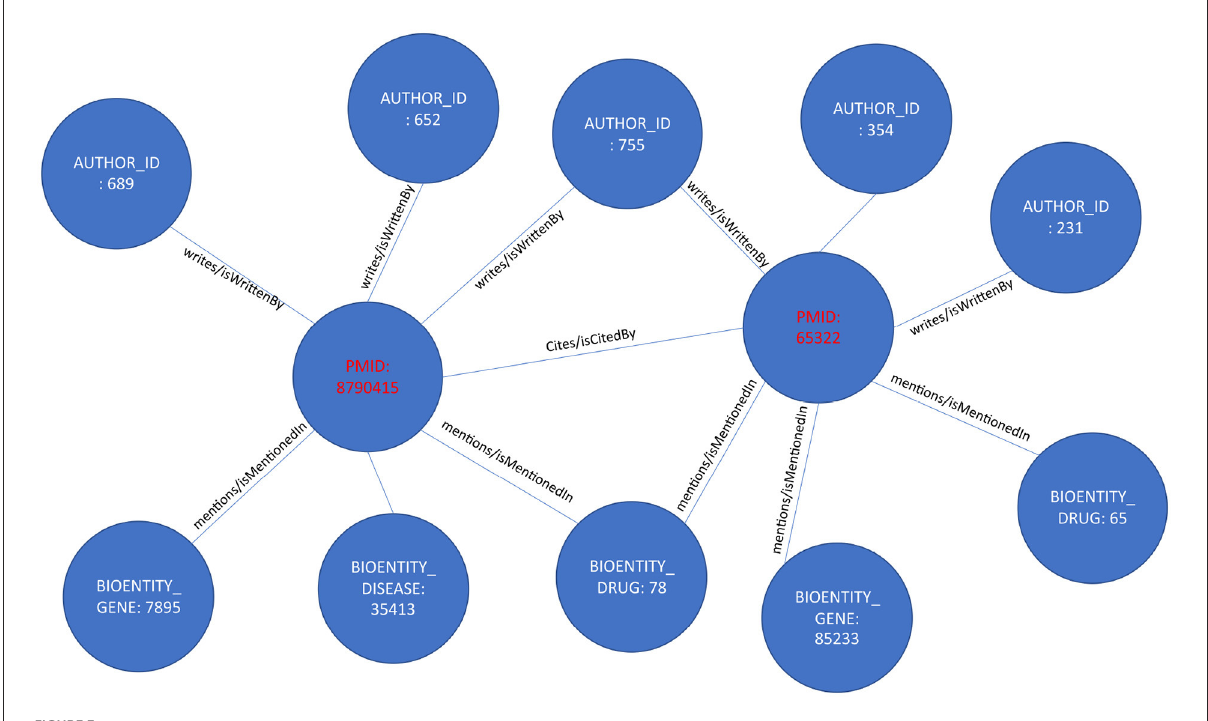
FIGURE3 A part of the extracted knowledge